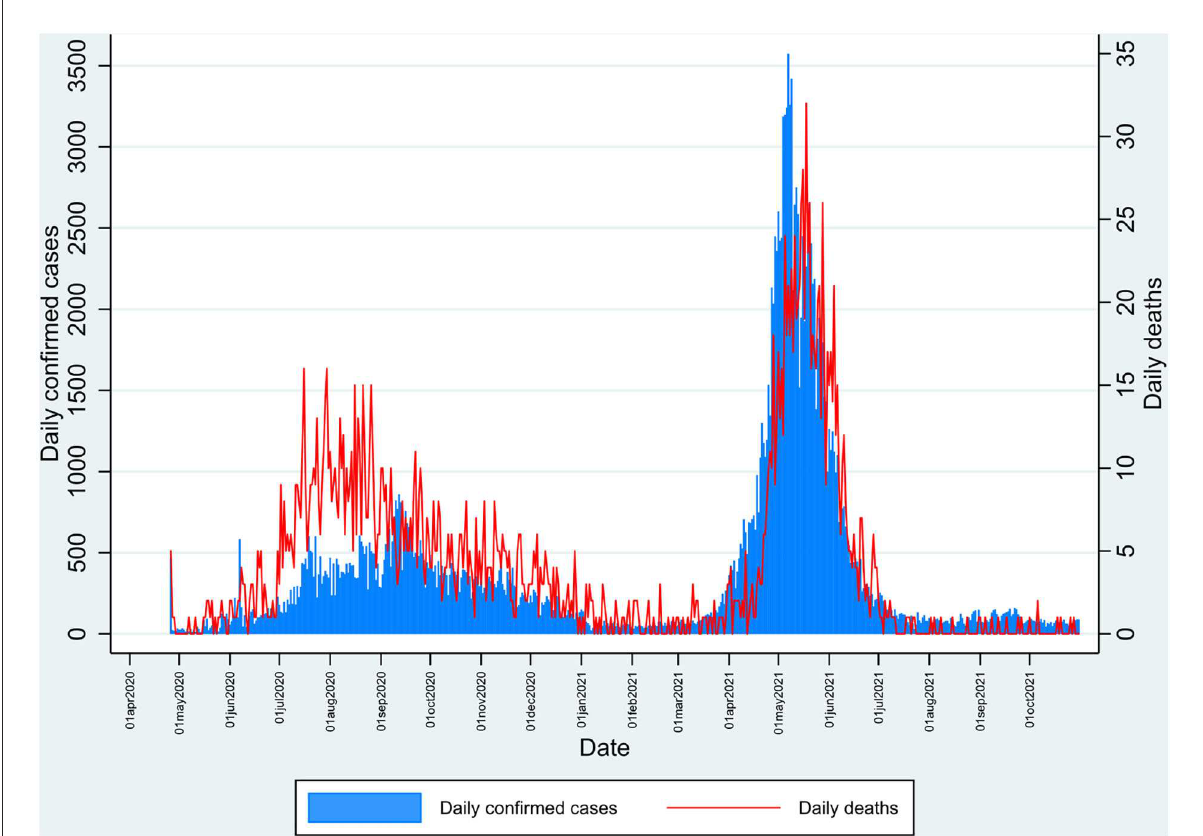
FIGURE2 Daily number of reported cases and deaths in Kashmir during the pandemic of SARS-CoV-2 from April 2020 to October 2021 depicting the first and second peak